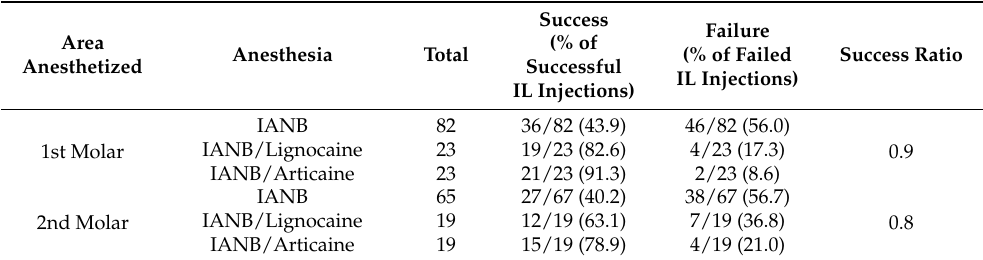
Table 2. Thesuccess ratio of supplemental intra-ligamentary lignocaine and articaine anesthesia in symptomatic irreversible pulpitis